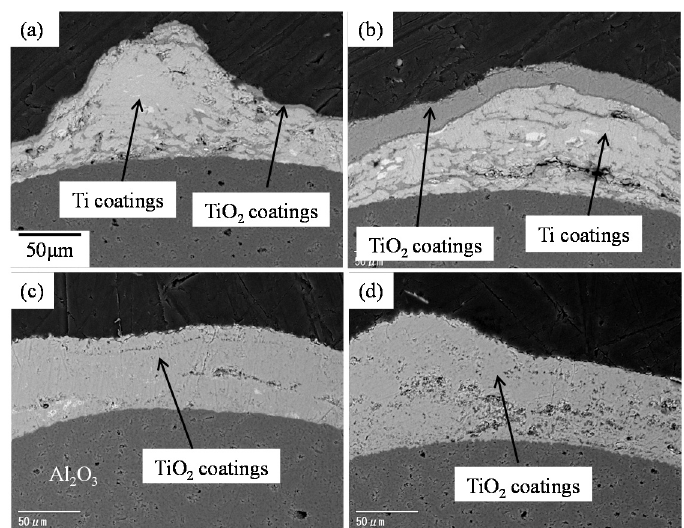
Figure 44. XRD patterns of M10- x Ni coatings after oxidation.